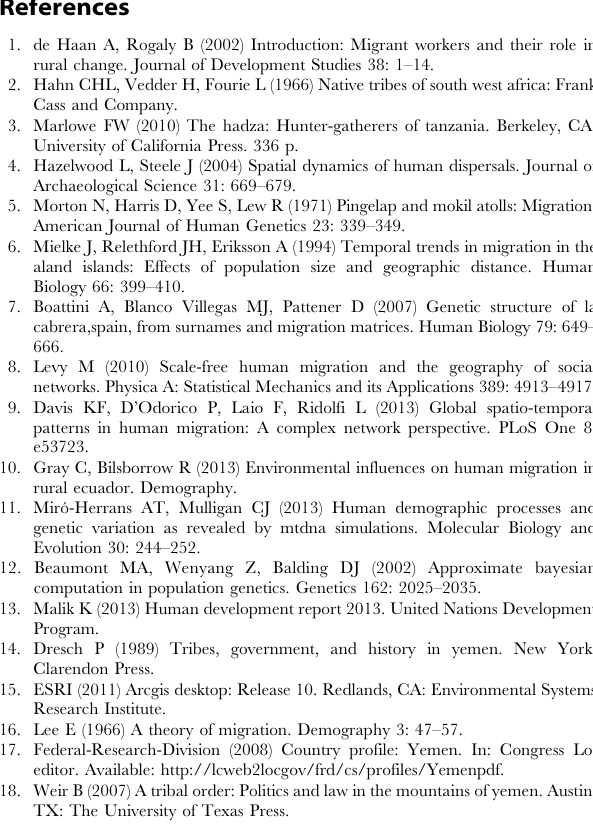
Figure S1 Migration direction vectors and mean migra- tion direction for each collection site by generation arrows: migration vectors. Large arrows: mean migration direction. (TIF) Table S1 Directional means estimates for each group by collection